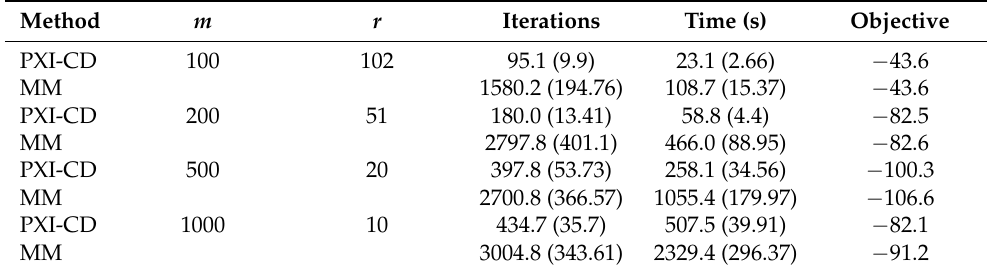
Table 7. The running times (s)—mouse